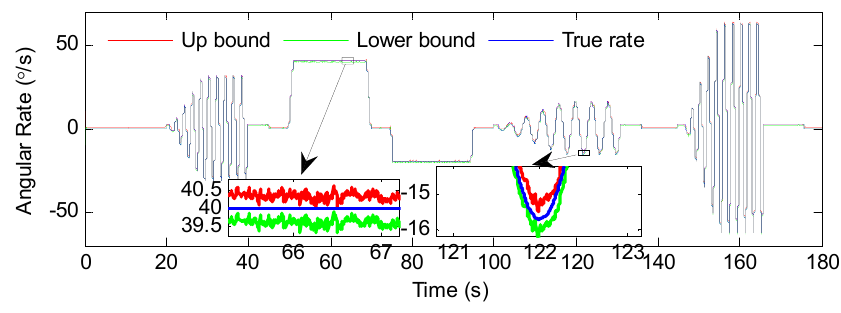
Figure 8. The estimated bounds by MMCF.